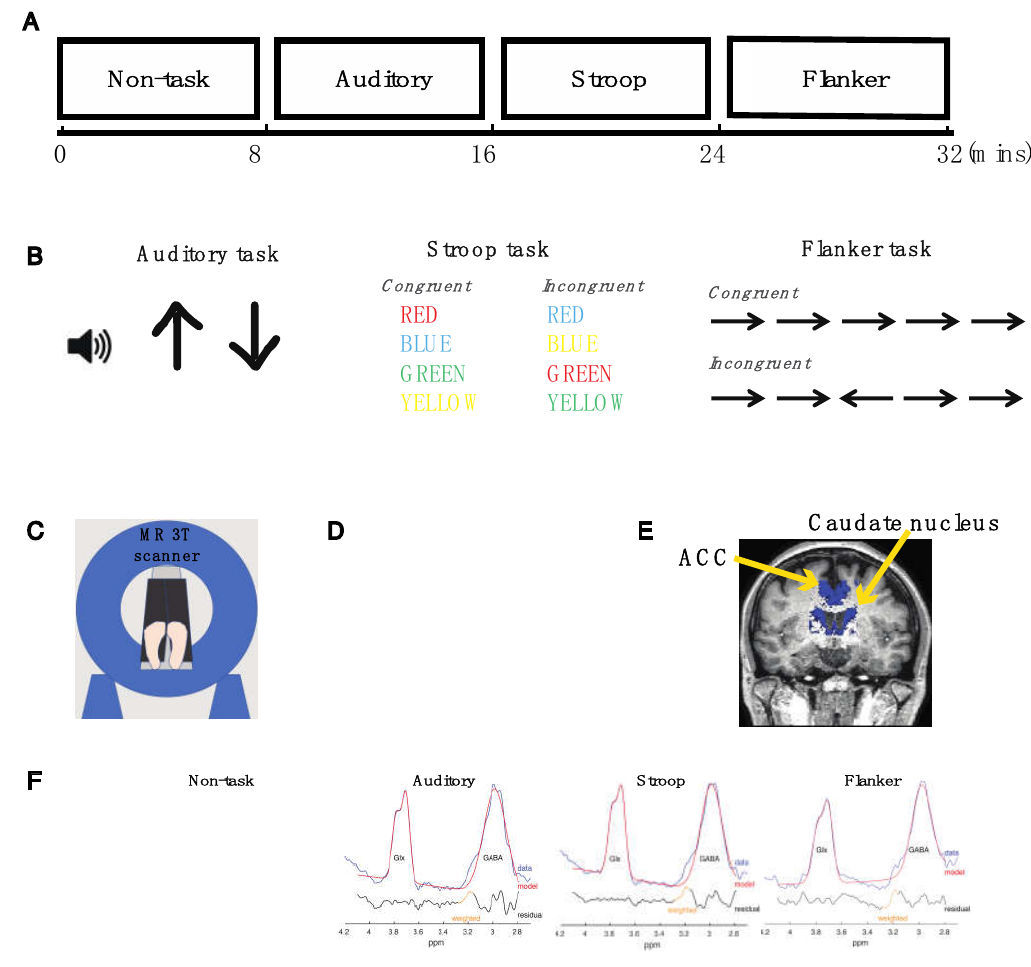
Figure 4. The experimental design, the voxel placement, and the quantification of Glx and GABA concentrations in the MRS experiment. ( A ) The entire MRS scan was divided into four blocks of time. Each block lasted eight minutes. In the 1st block, subjects were not required to perform any tasks and remained still insides the scanner. In the subsequent blocks, subjects performed auditory, Stroop, and Flanker tasks. ( B ) Three attention control tasks were administered during the MRS scan: study participants listened to two competing tones in the auditory task; study participants reported the colors of various fonts in the Stroop task; study participants reported the arrow direction of the center image in the Flanker task. ( C ) An illustration of a participant laying still inside a Philips Achieva 3T scanner. ( D ) The voxel placement overlaid on a subject’s T1-weighted image shown in the axial plane. ( E ) The anterior cingulate cortex (ACC) and the caudate nucleus within the MRS voxels shown in a T1-weighted image in the coronal plane. ( F ) Representative fits of a single GABA peak at 3 parts per million (ppm) and a double Glx peak at 3.75 ppm in the edited MEGA-PRESS spectrum during the non-task and task conditions. The red trace is the model fit overlaid on the raw MRS data.